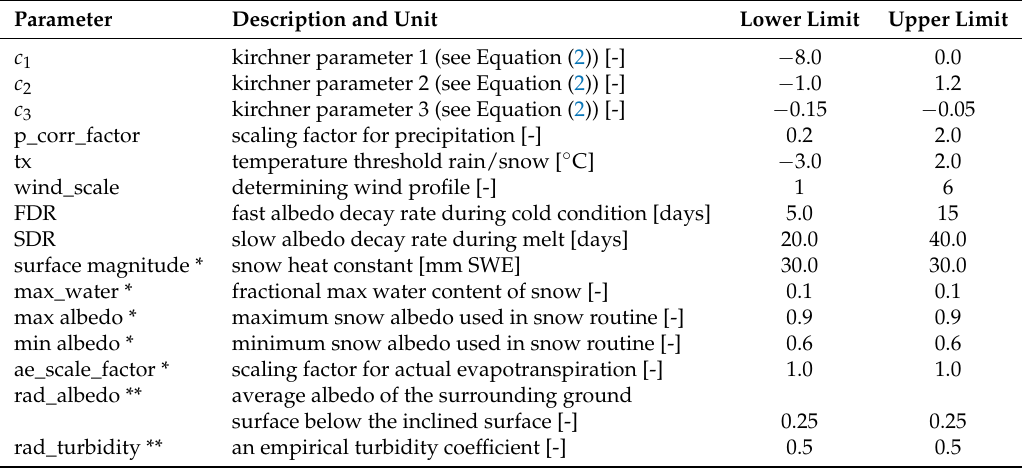
Table 2. Model calibration parameters with upper and lower limits. Prescribed parameters are marked with *. Parameters only used in radiation model are marked with **.